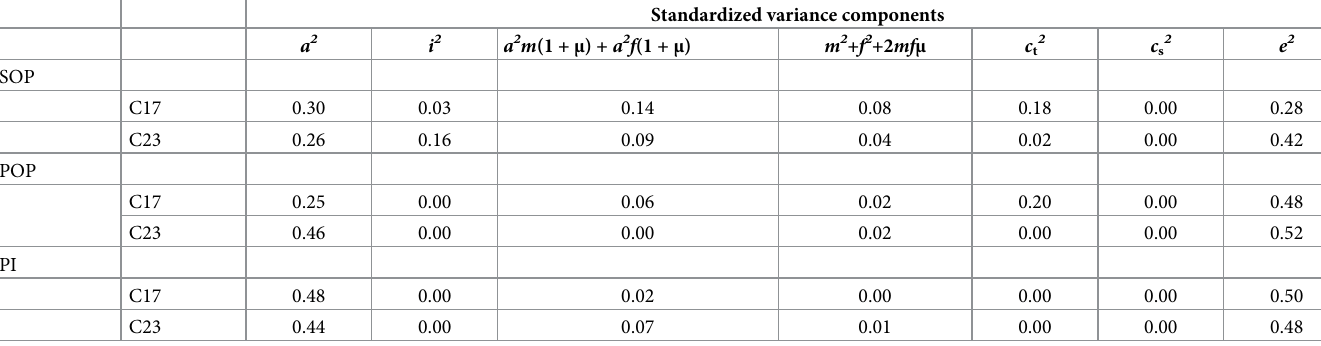
Table 4. Variance components derived from the best fitting, most parsimonious ETFD